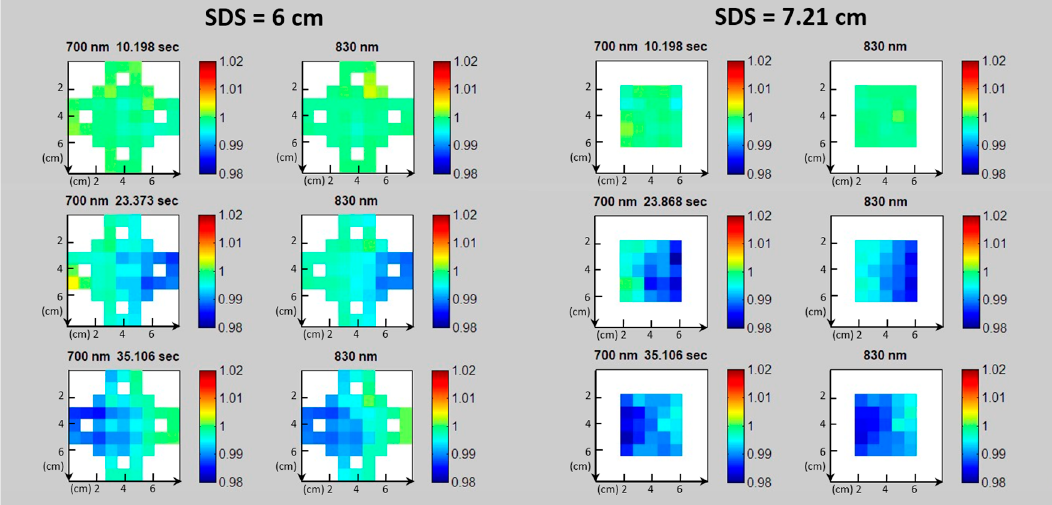
Figure 10. Back-projection images reporting the normalized photocurrents after 700 nm and 830 nm irradiation, related to three different instants for 6 cm and 7.21 cm SDSs.